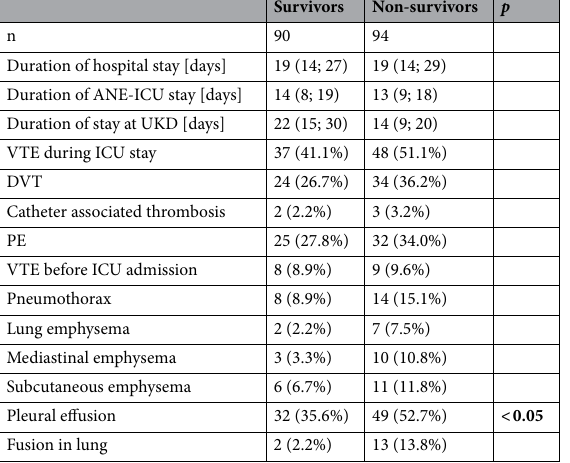
Table 6. ICU outcome survival. Data are median (Interquartile range) or n (%). Significant values are in [bold]. ICU Intensive care unit, ANE‑ICU Intensive care unit of the Department of Anesthesiology and